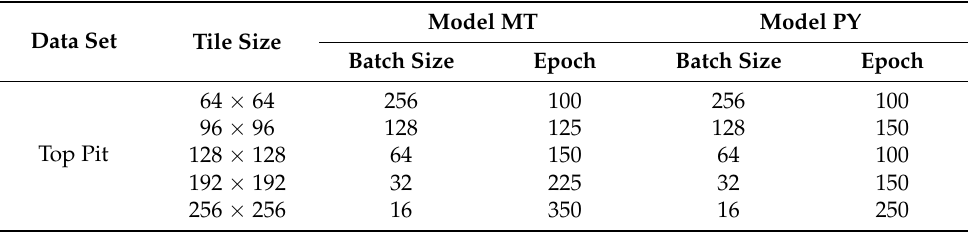
Table 6. Batch sizes and training epochs used during model training for Top Pit and Pick